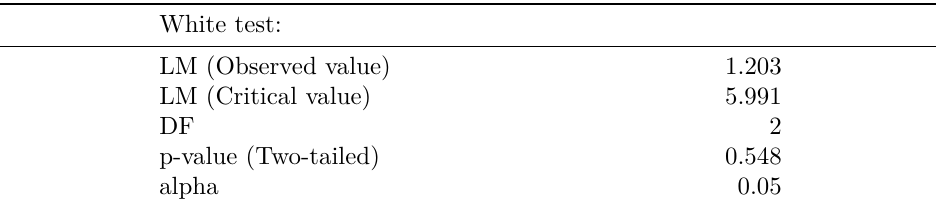
Table A.3: Heteroscedasticity test of Model 3